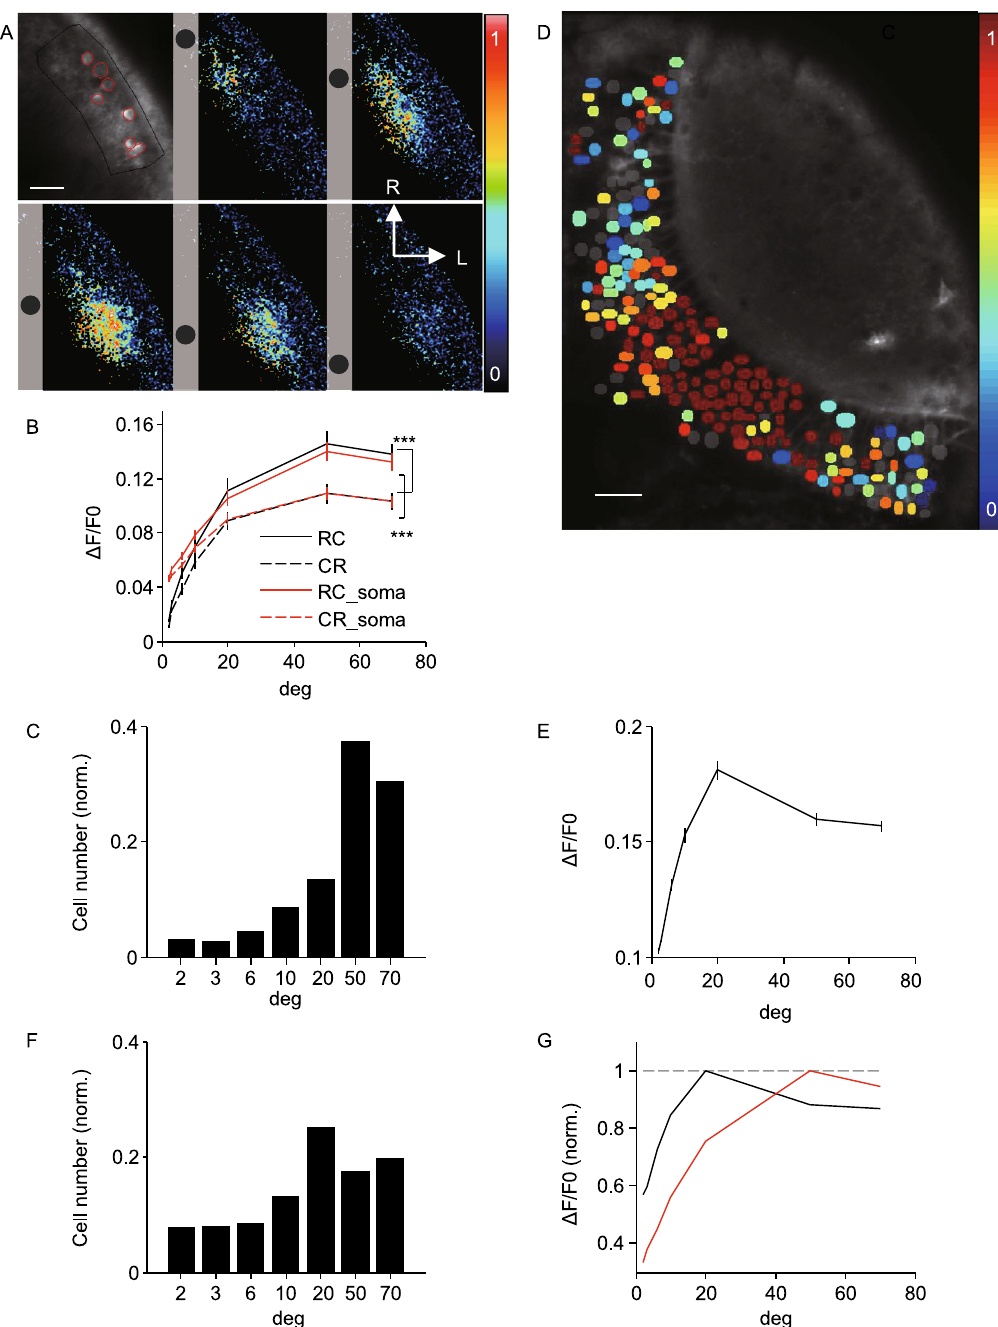
Figure 3. Size tuning of SINs. (A) Montage showing responses of SINs to moving dot stimulus of 10°, color-coded according to normalized responses. Relative position in each panel indicates direction of motion. Top left, fl uorescence image showing analyzed ROIs demarcated by lines (population in black; somata in red). (B) Summary of responses to moving dots from population ( n = 47 fi shes, P = 2.3 × 10 − 10 , two-way ANOVA) and responsive somata ( n = 254/338, P = 1.8 × 10 − 9 , two-way ANOVA). (C) Size preference distribution for all somata ( n = 254/338 cells from 47 fi shes). (D) Responses of PVNs to moving dot stimulus of 20°, color-coded according to normalized responses. Gray somata showing nonresponsive cells. (E) Summary of responses to moving dots from all somata ( n = 1,651). (F) Size preference distribution from all somata. (G) Comparison of tuning curves between SINs (red) and PVNs